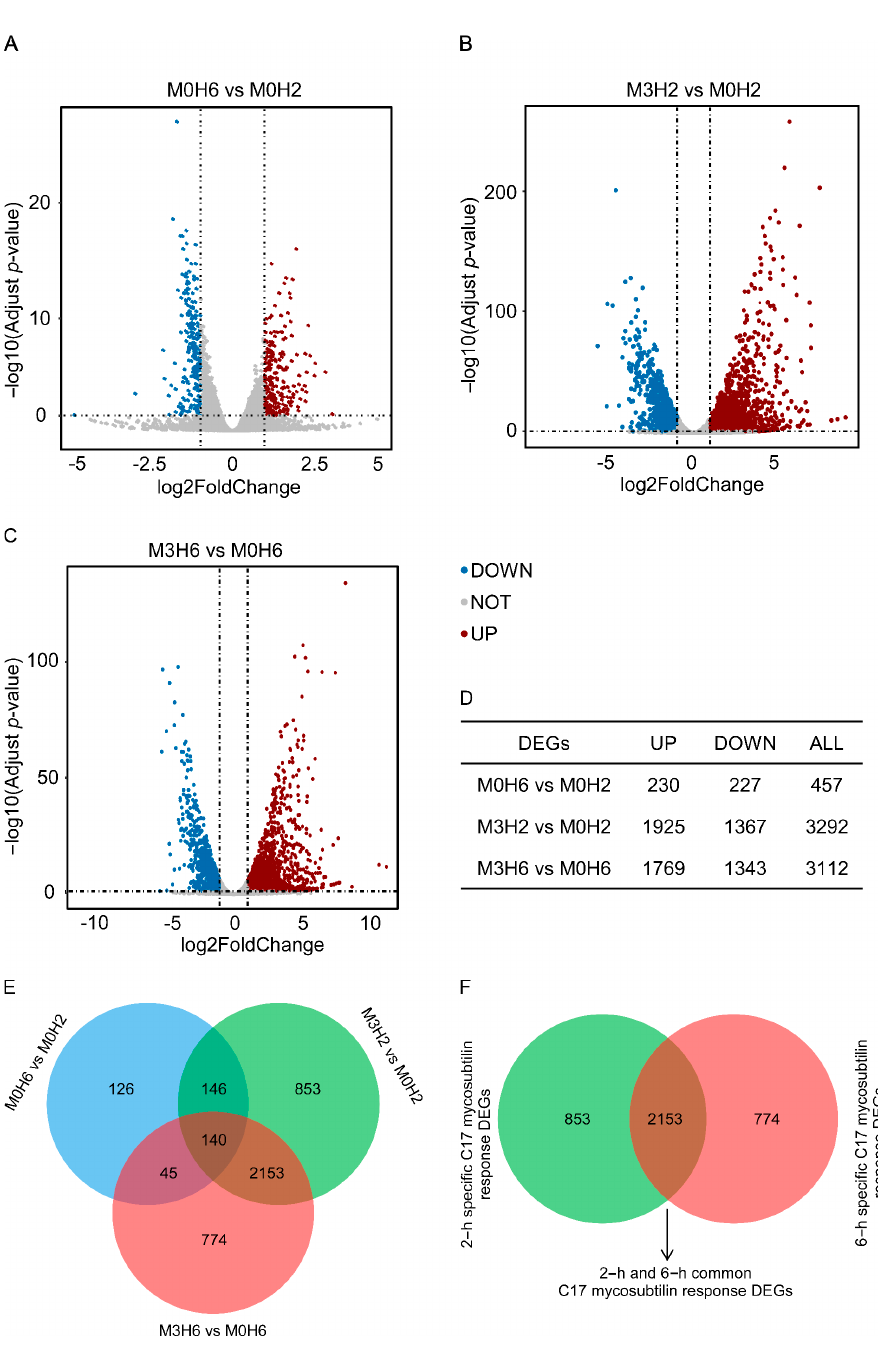
Figure 4. C17-mycosubtilin-responsible genes in Vd 991 spores after treatment at different times. ( A – C ) Volcano map of differentially expressed genes. Genes with a Padj (adjusted p -value) <0.05 and absolute fold change ≥ 2 were significantly DEGs. The red dots represent genes that are significantly upregulated, the blue dots represent genes that are significantly downregulated, and the grey dots represent genes that are not significantly differentiated. M0H6 and M0H2 indicated that the spores grew naturally in Czapek–Dox broth medium without C17 mycosubtilin treatment for 6 h and 2 h, respectively; M3H6 and M3H2 indicated that the spores grew in Czapek–Dox broth medium containing C17 mycosubtilin at the IC50 concentration for 6 h and 2 h, respectively. ( D ) Statistical results of different genes of each group. ( E ) Venn diagram of each group of differentially expressed genes. ( F ) Venn diagram after excluding differentially expressed genes produced in the natural growth